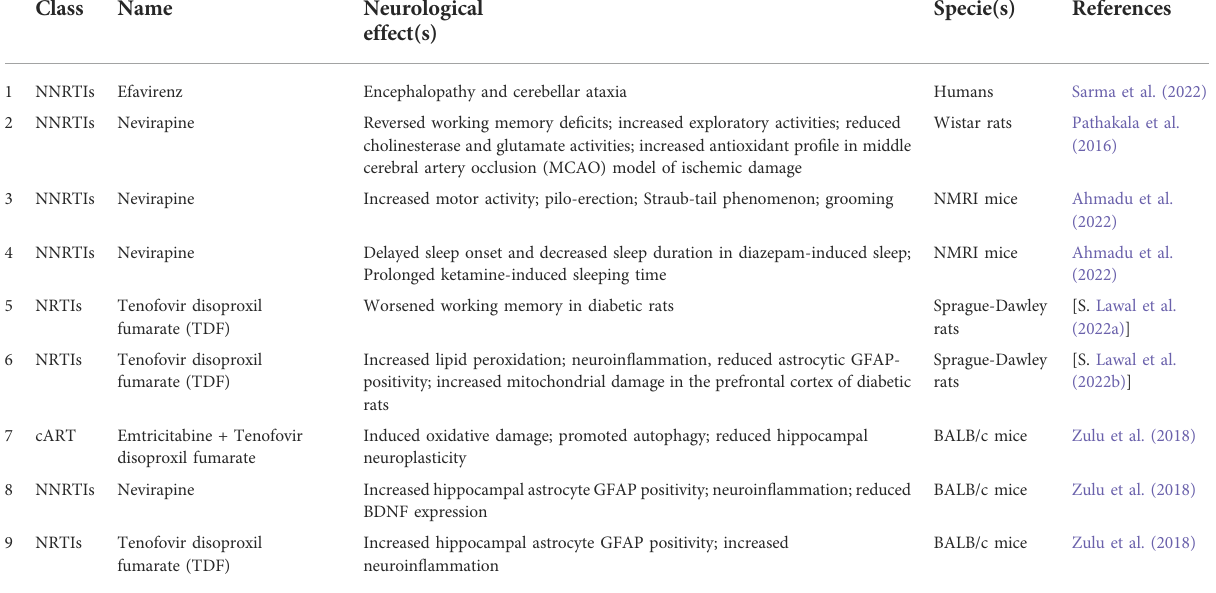
TABLE 1 Summary of neurological effects of